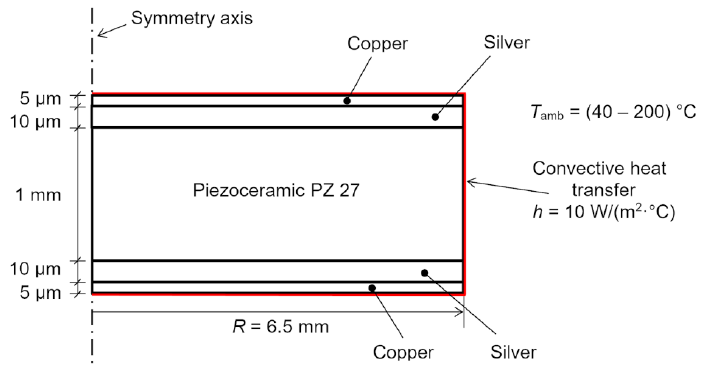
Figure 3. Graphical representation of the finite element model. Dimensions are not to scale. Thermal stresses in the investigated structure were evaluated in a term of von Mises stress. The von Mises stress is scalar quantity and criterion of yield very often used for metals. If the von Mises stress is greater than the yield strength of the material, then the material will yield. The distribution of von Mises stress in the piezoelectric ceramic disc coated with silver and a copper layer at 200 °C is presented in Figure 4.